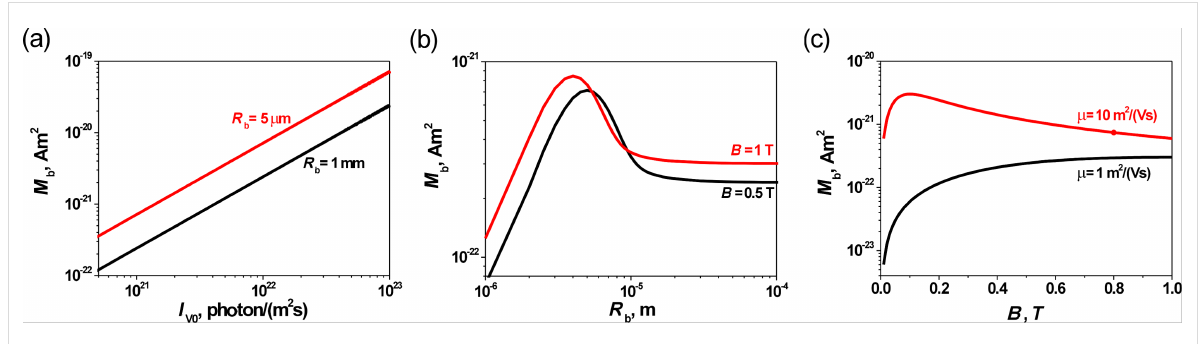
Figure 2: The calculated dependences of the PME magnetic flux: (a) vs the illumination intensity for different values of the beam radius ( B = 0.5 T; μ = 1 m 2 V − 1 s − 1 ; τ = 10 − 10 s); (b) vs the beam radius for varying values of the magnetic field ( μ = 1 m 2 V − 1 s − 1 ; τ = 10 − 10 s; I V0 = 10 21 photons/(m 2 s)); (c)